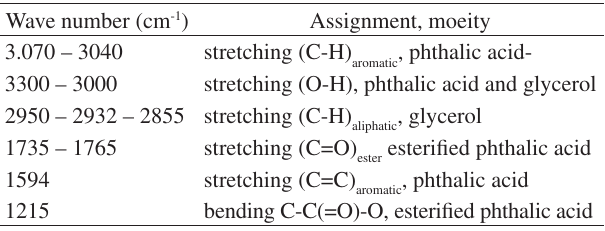
Table 2. Most important absorption and corresponding